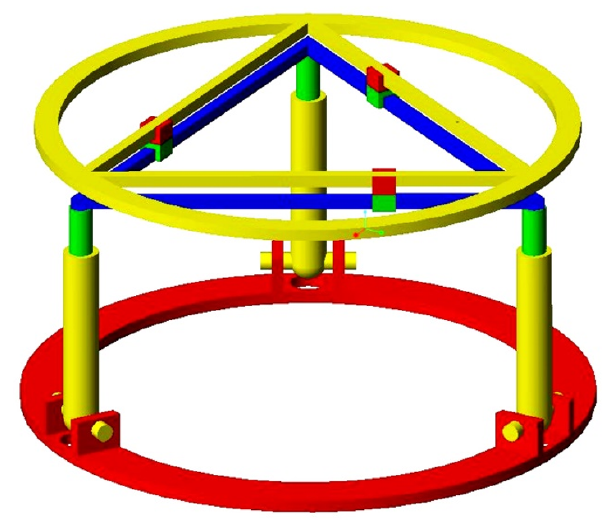
Figure 7. Singular configuration associated with double triangular